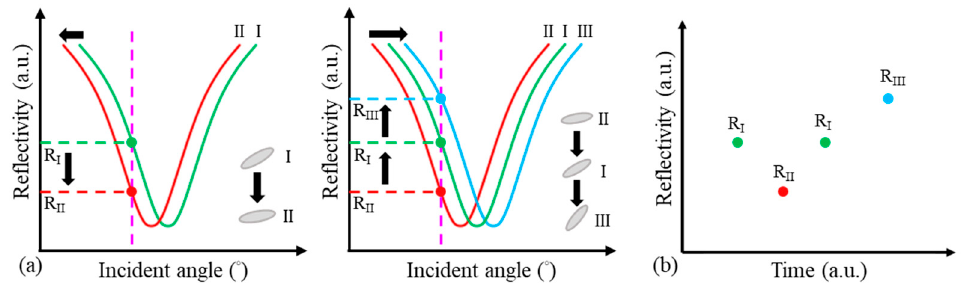
Figure 3. ( a ) As the average effective tilt angle 𝜃′ decreases, the resulting decrease in the resonance angle α , along with the left-shift in the whole curve, reflects a decrease in the reflectivity R measured at a fixed angle (dash line). Conversely, the reflectivity R increases with the effective angle 𝜃′ . ( b ) The evolution of the reflectivity was recorded continually with time.